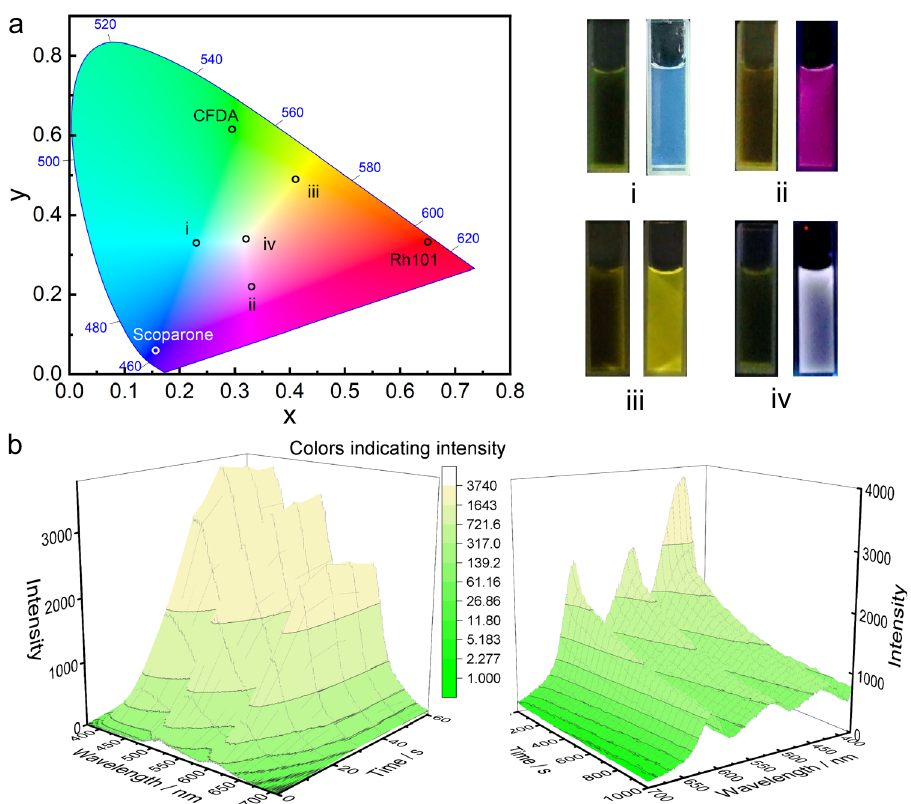
Fig. 7 Orthogonal combination of the fl uorophores loaded in the photodeformable supramolecular DSAs for more metastable fl uorescent colors. a CIE 1931 images of light-induced fl uorescent color sites in different fl uorescent combinations and the corresponding fl uorescence picture ((i) Scoparone + CFDA, (ii) Scoparone + Rh101, (iii) CFDA + Rh101, (iv) Scoparone + CFDA + Rh101). b 3D fl uorescence spectra of light-induced process and thermal deformation process loading scoparone, CFDA and Rh101 for controllable of pure white emission. ([Scoparone] = 0.0002 mM, [CFDA] = 0.025mM, [Rh101] = 0.004mM) ([SMC] initial = 0.225 mM, [PEI] = 5 μ g mL − 1